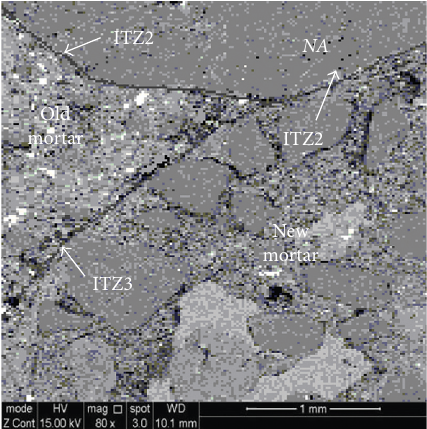
Figure 11: SEM image explains the ITZs in RAC sample without